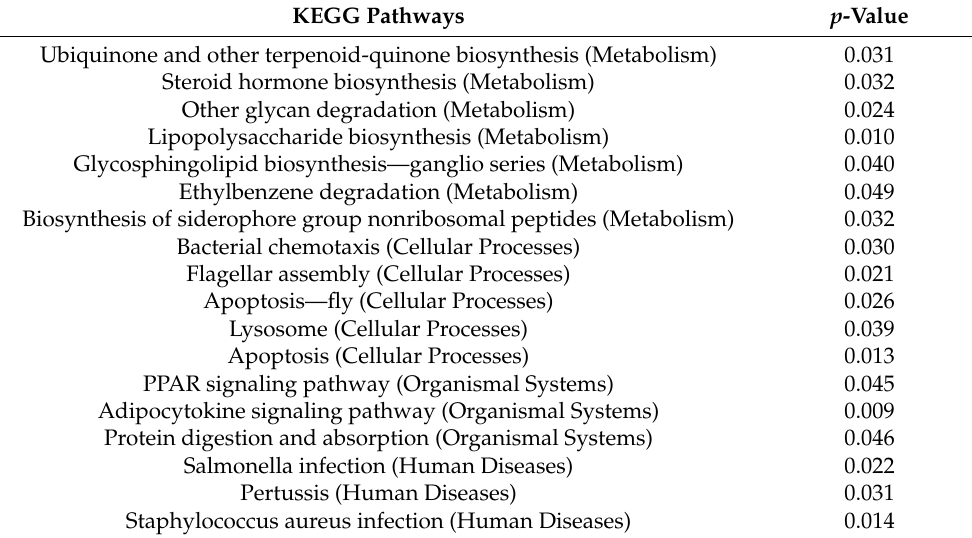
Table 6. KEGG pathways with significantly different abundances in the colonic microbiota of Brandt’s